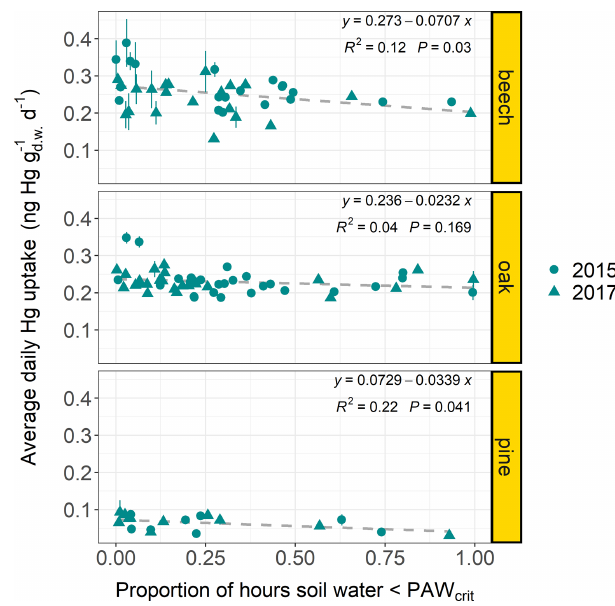
Figure 6. Average daily Hg uptake rates (ngHgg − 1 d − 1 ) of beech, d.w. oak, and current-season pine foliage from multiple forest plots (beech plots n = 38; oak plots n = 45; pine plots n = 19; latitude: 41–55 ◦ ) versus the proportion of hours within the respective sample life periods, during which the geographically associated hourly soil water from the ERA5-Land dataset (Muñoz Sabater, 2019) fell be- low a soil-texture-specific threshold value PAW crit (see Sect. 2.6). Data points originate from both sampling years 2015 and 2017. Er- ror bars denote ± 1 standard deviation of daily needle Hg uptake rates between multiple samples at each forest